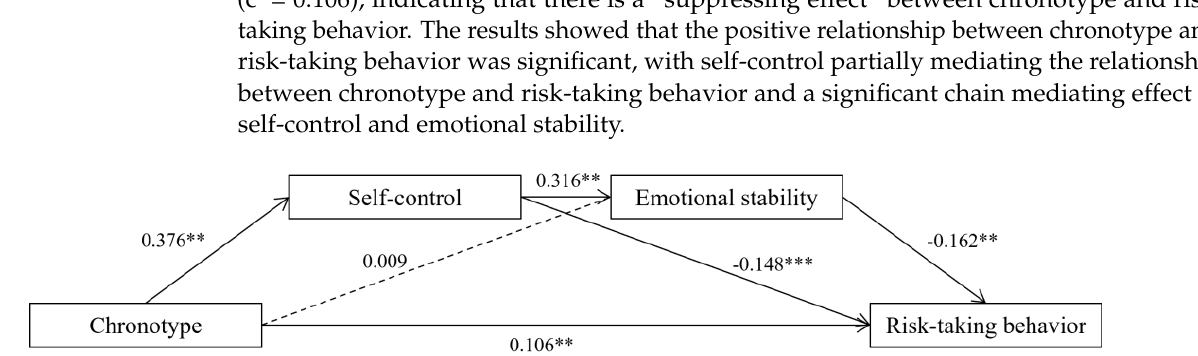
Table 3. Standardized indirect effects and 95% CIs for the mediational model ( n = 296).